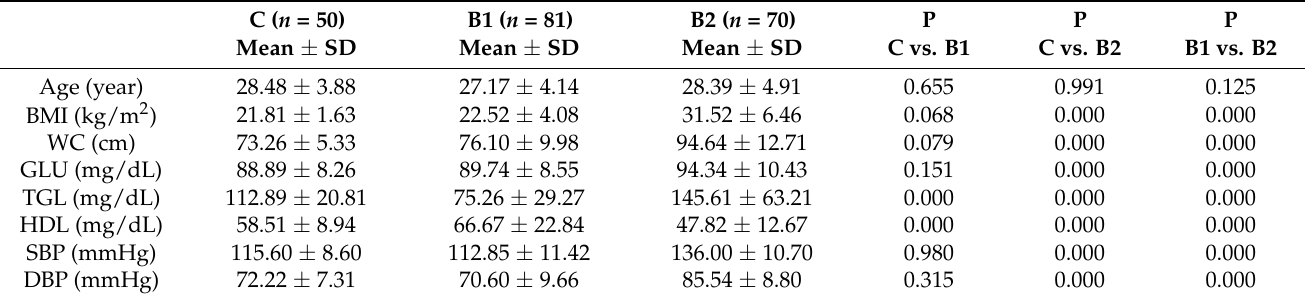
Table 1. The characteristics of the study